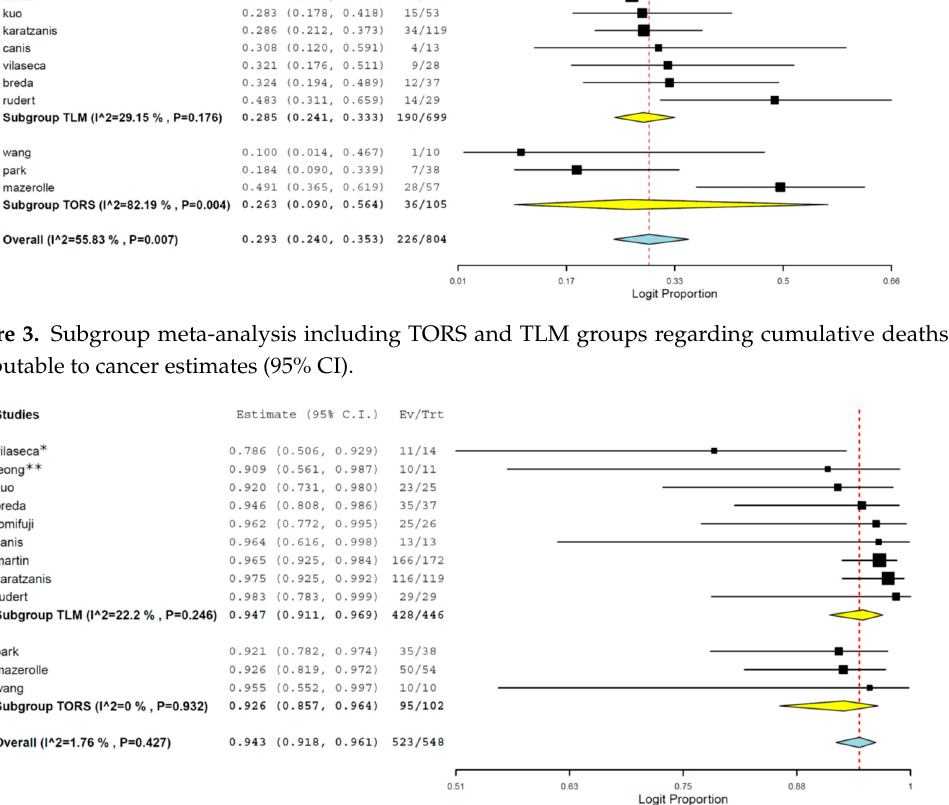
Figure 4. Subgroup meta-analysis including TORS and TLM groups regarding swallowing and voice function preservation estimates (95% CI). * Only patients without recurrence were evaluated for this outcome **. One patient was not treated with curative intent.